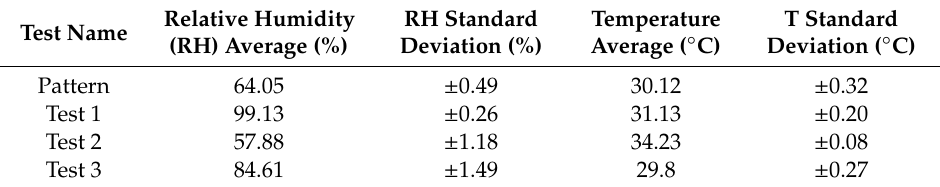
Table 2. Tests designed. Source: Authors.